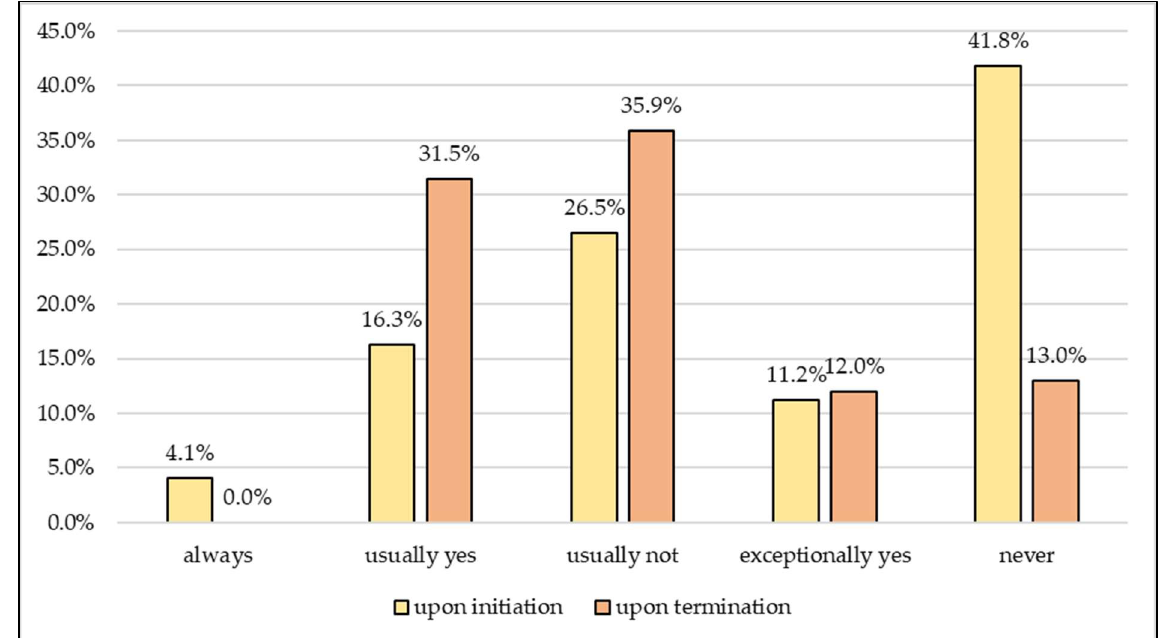
Figure 7. Involvement of forensic experts in the procedure ( n = 99).